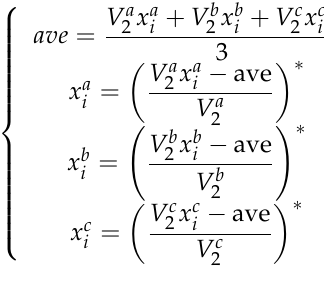
was the best in whole GB